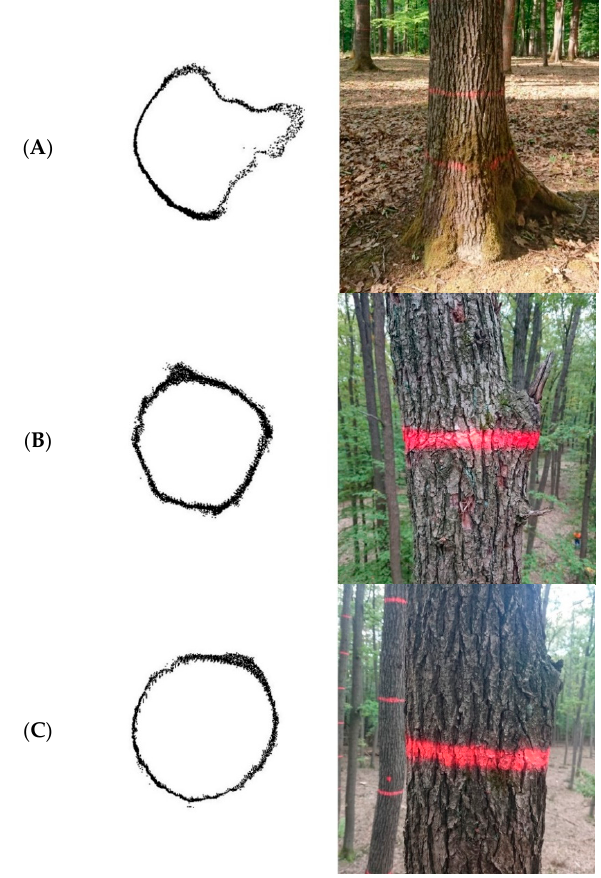
Figure 9. Examples of irregular shape caused by ( A ) root crown; ( B ) rest of fallen branch; and, ( C )